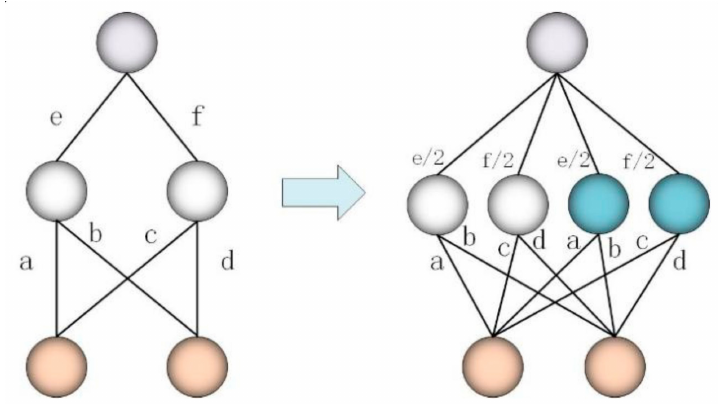
Figure 5. Perform a step to expand the network width